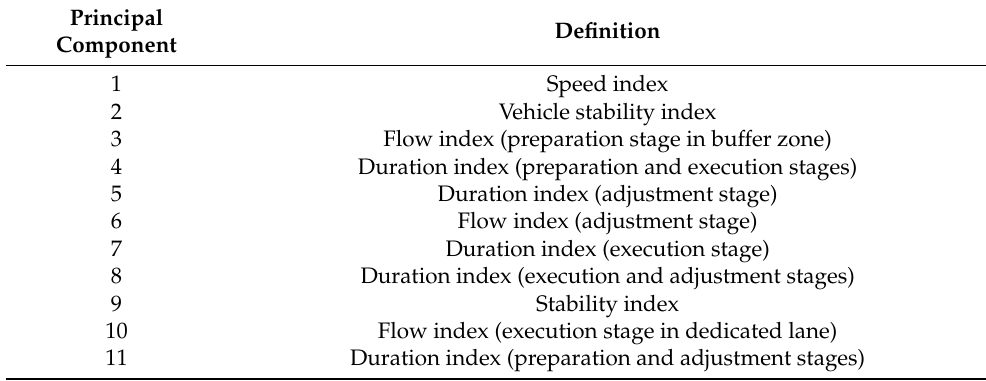
Table 5. Explanations for each principal